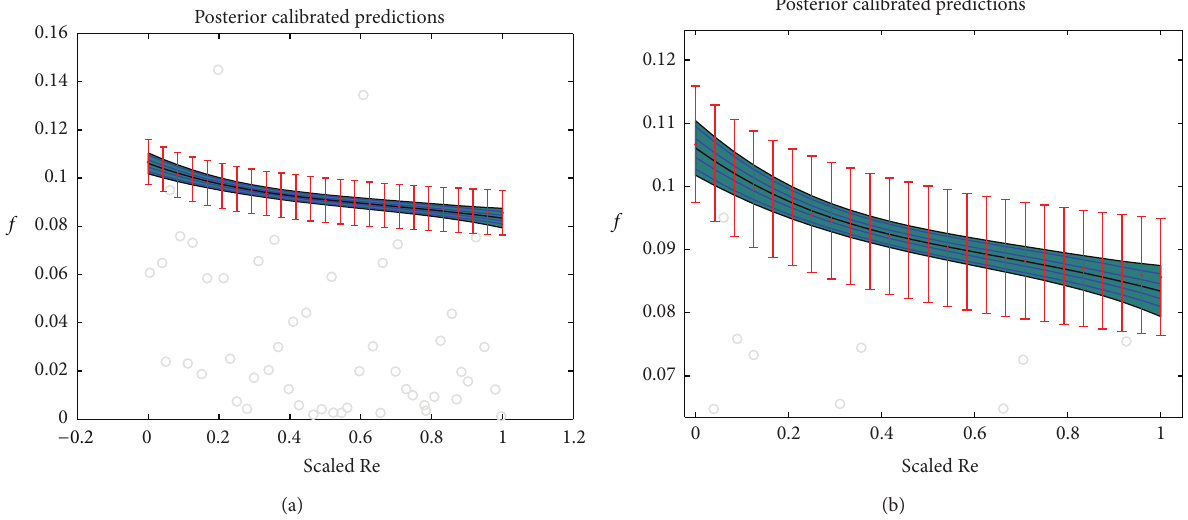
Figure 11: GP calibrated posterior predictions ((a) covers entire training set; (b) zoom in on the observational data). some spacing between the green band’s edge and the outer